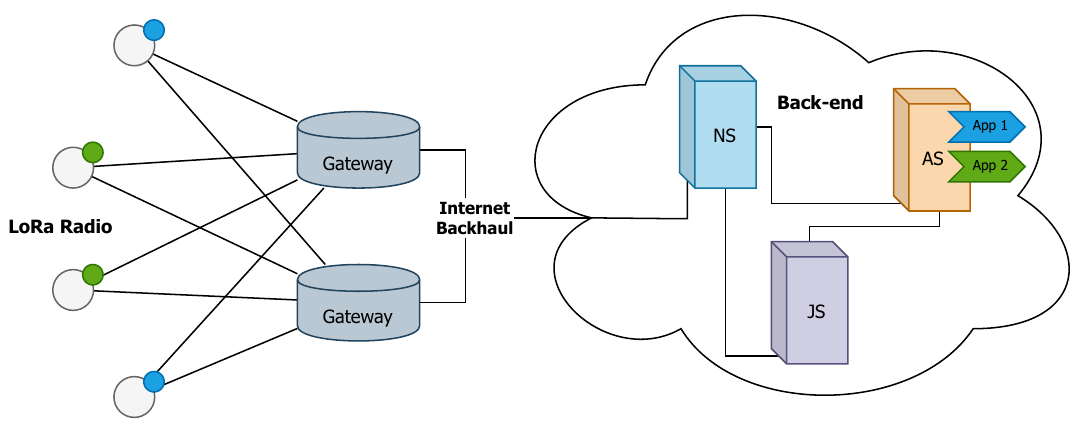
Figure 1. LoRaWAN